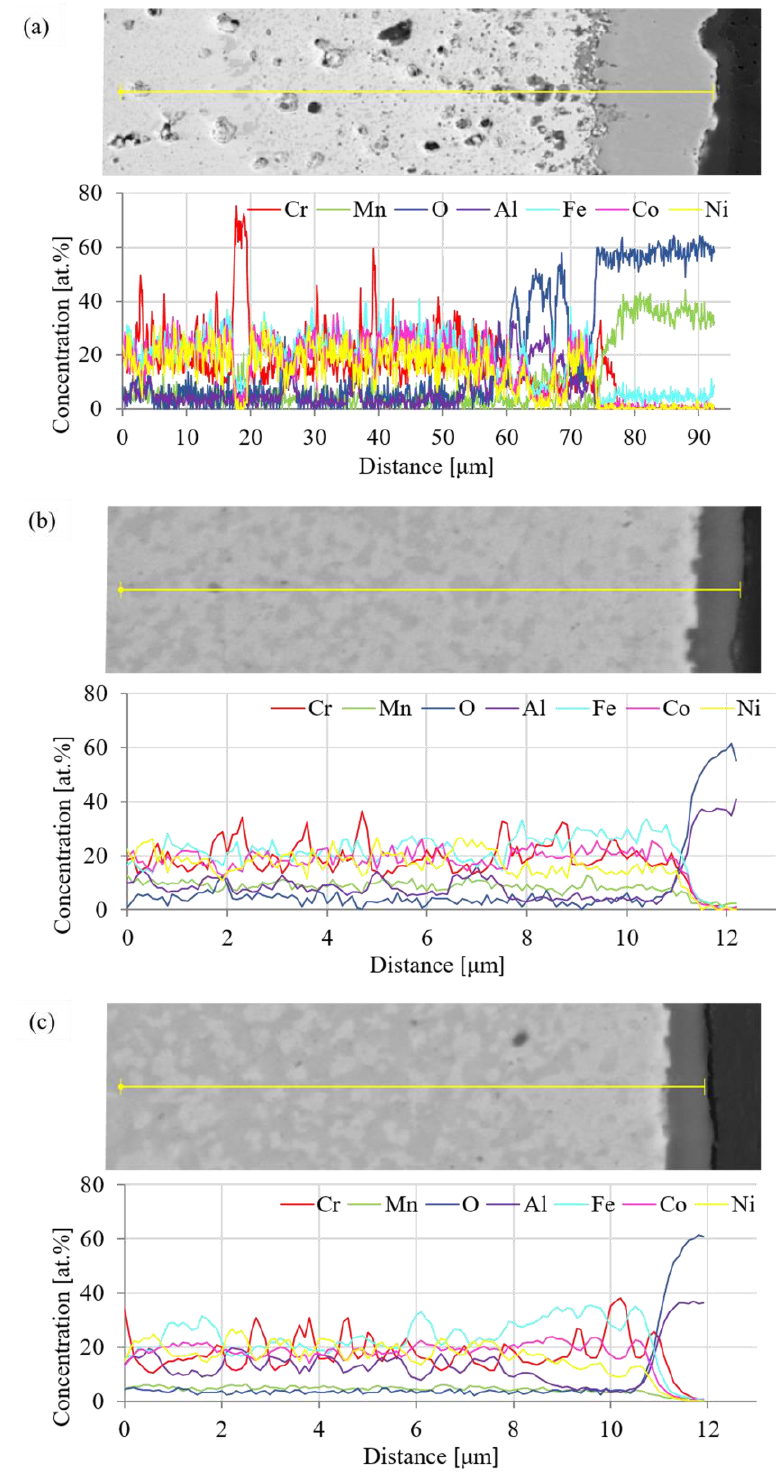
Figure 16. Quantified SEM + EDS line analysis (yellow line) across the oxide layers formed after 100 h annealing at 800 ◦ C: ( a ) Mn15Al5, ( b ) Mn10Al10, ( c )